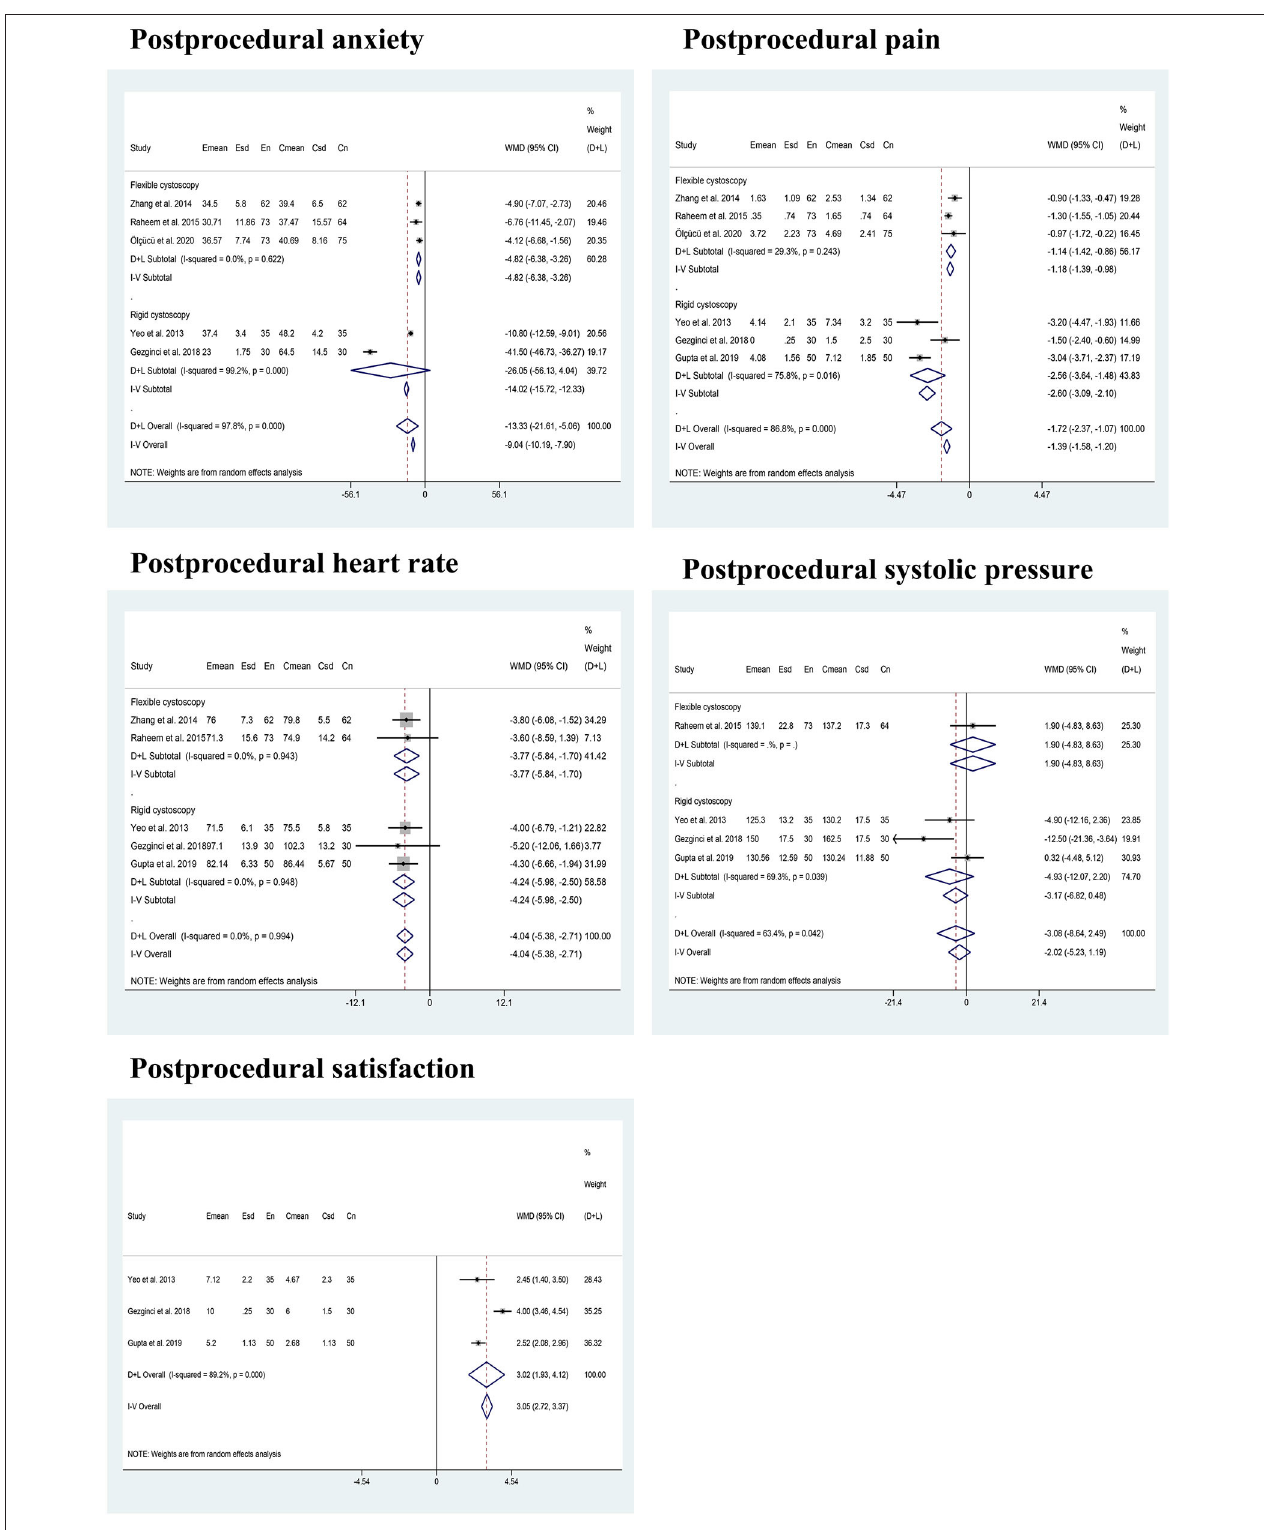
FIGURE 3 | The pooled results of the evaluated outcomes in this study.